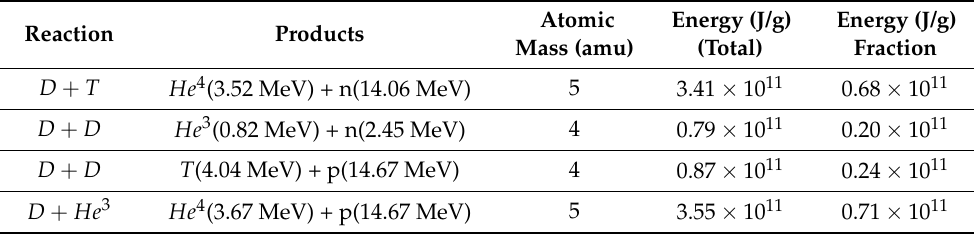
Table 3. Energy release ( J / g ) for various fusion reactions. The total includes all particle energies but fraction refers to the energy release from all products minus the protons and neutrons for the heavy ion energy deposition rate.